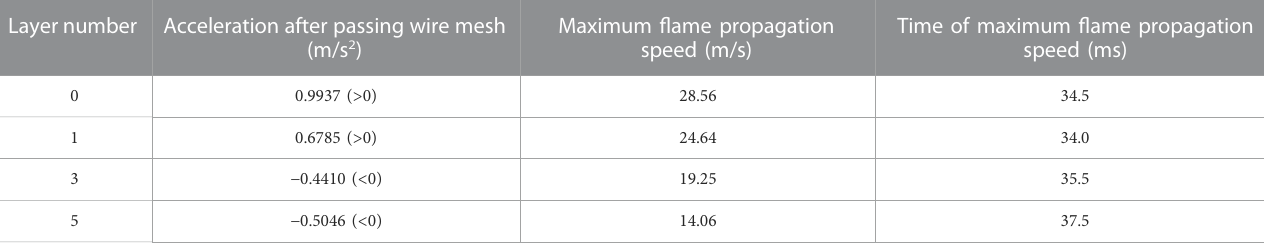
TABLE 2 Characteristic values of fl ame propagation speed. Layer